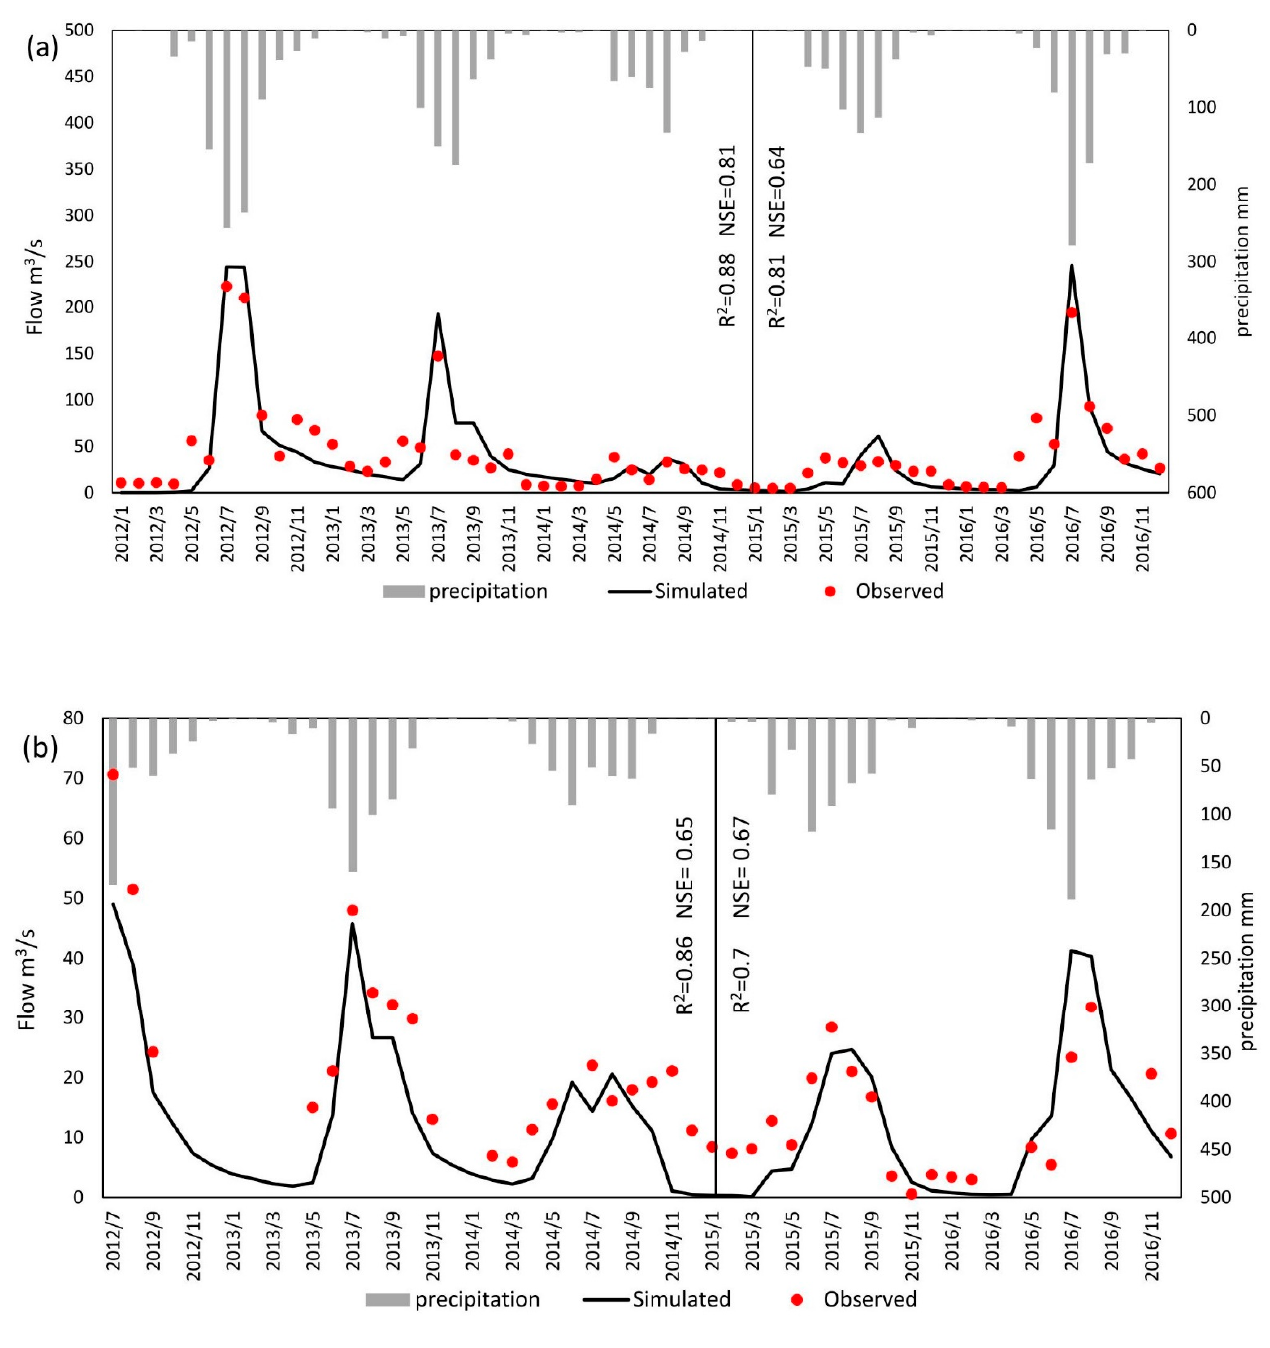
Figure 4. Calibration and validation results of streamflow from 2012 to 2016 in ( a ) Luanxian and ( b ) Wulongji stations. Table 1. Performance rating (PR) for streamflow prediction by SWAT.